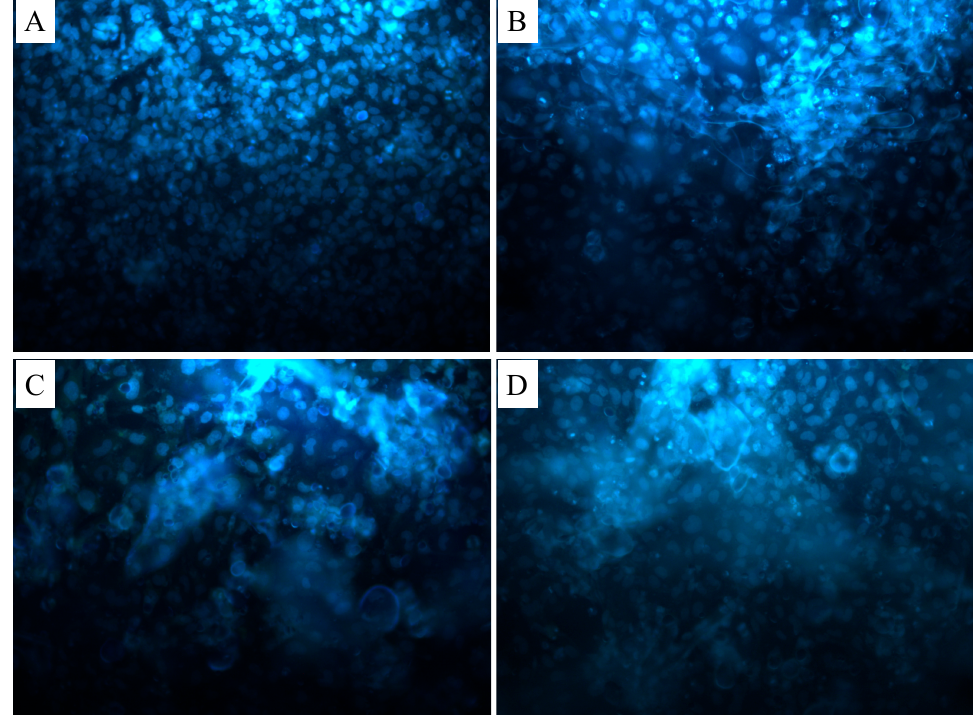
Figure 7. Fluorescence microscopy images of human osteoblast cells on ( A ) PCL/GEL, ( B ) PCL/GEL/BC, ( C ) PCL/GEL/BC/0.25%HA, ( D ) PCL/GEL/BC/0.50%HA scaffolds.